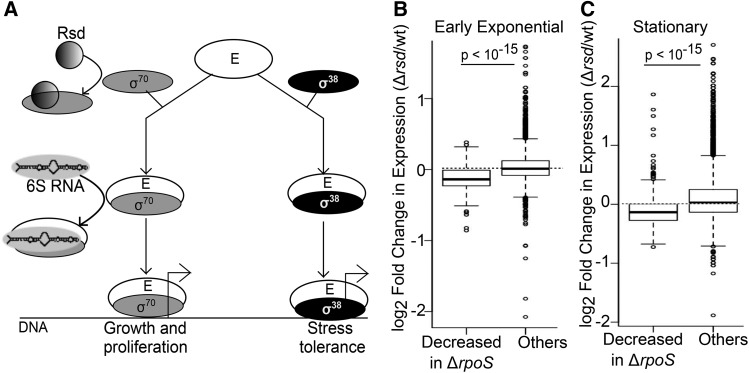
Rsd regulates RpoS target genes throughout growth. (A) Schematic showing the binding activity of Rsd and 6S RNA. (B) Boxplot of log2 fold change in gene expression (Δrsd/wild-type, EE phase) for 313 genes whose expression is reduced at least twofold in ΔrpoS/wild-type in EE phase, compared to all other genes. (C) Boxplot of log2 fold change in gene expression (Δrsd/wild-type, stationary phase) for 634 genes whose expression is reduced at least twofold in ΔrpoS/wild-type in stationary phase, compared to all other genes. p-values are for Wilcoxon Test.